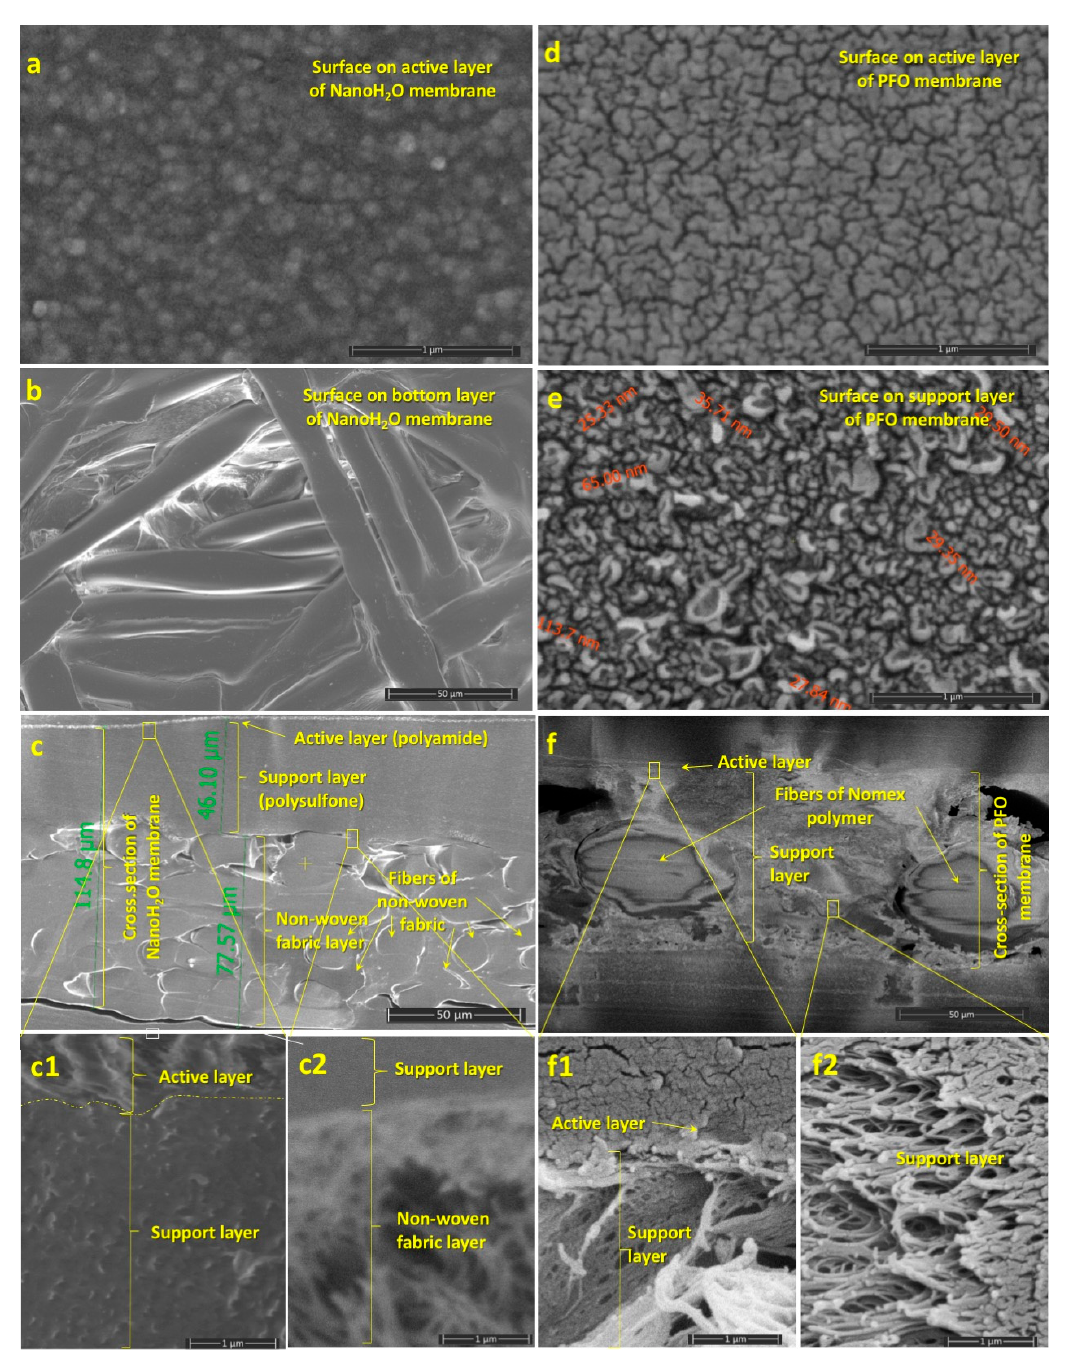
Figure 1. SEM images of the surface and cross-section structure of two membranes used in experiments: QuantumFlux (NanoH 2 O) membrane ( a – c ) and PFO (Porifera) membrane ( d – f ). ( a ) Surface structure of the active layer of NanoH 2 O membrane; ( b ) surface structure of the support, or non-woven fabric, layer of NanoH 2 O membrane with observable circular fibers (15–25 µ m thick); ( c ) the cross-section of NanoH 2 O membrane contains a thin (500–900 nm) active layer and a thick (70–80 µ m) porous support layer, which can result in unique separation features; ( d ) the active surface of PFO membrane; ( e ) the surface of the support layer of PFO membrane; ( f ) the cross-section of PFO membrane contains a very thin active layer ( f1 ) and porous sponge-like support layer ( f2 ). PFO membrane fibers of Nomex polymer (50 µ m thick) are also well